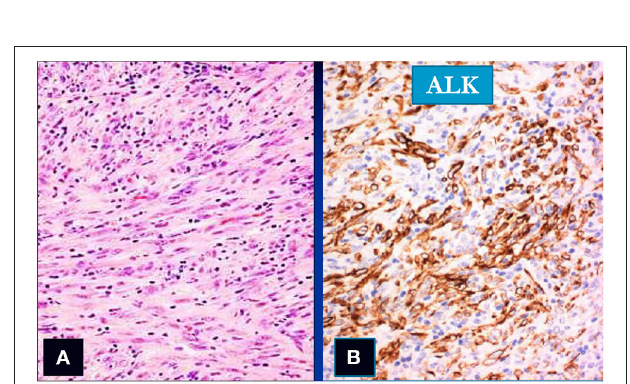
FIGURE 6 | Spindle cells showing positivity for the actin—muscle specific (A,B) and vimentin stain (C,D) (original magnification × 10: A ; × 40: C,D ; × 100: B ).